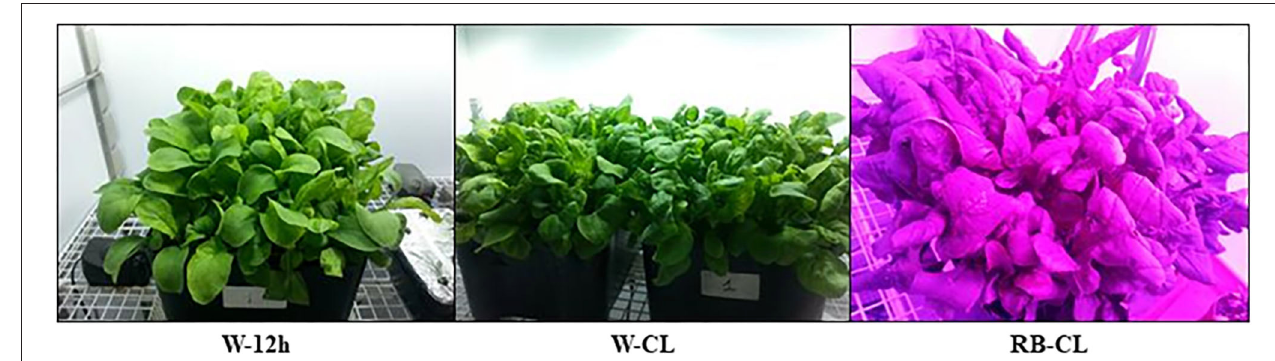
FIGURE 1 | Morphological differences in Eruca vesicaria (L.) Cav. grown under three different light-emitting diode (LED) treatment conditions. Treatment 1—(W-12h): photoperiod of 12-h light/12-h dark; photosynthetic photon flux density (PPFD) was 600 µ mol m − 2 s − 1 , LEDs W:FR:R:B = 12:2:71:15. Treatment 2—(W-CL): photoperiod of 24h continuous light (CL); PPFD was 300 µ mol m − 2 s − 1 , cool white LEDs. Treatment 3—(RB-CL): photoperiod of 24-h continuous light; PPFD was 300 µ mol m − 2 s − 1 , LEDs R:B = 73:27. All the light treatments received the same daylight integral (DLI) (25.92mol quanta m − 2 day − 1